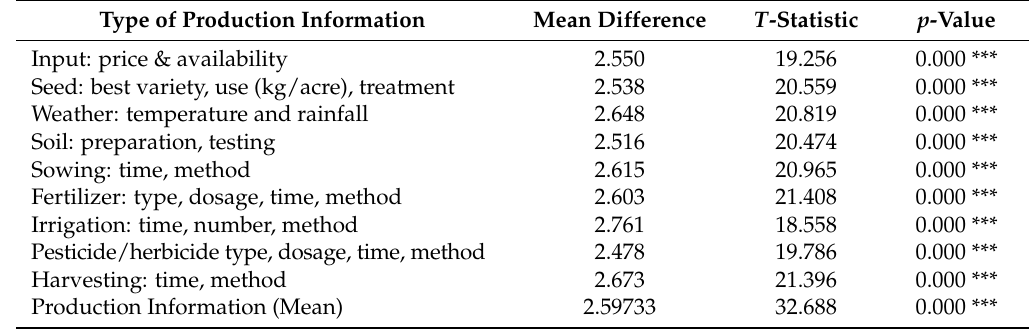
Table 4. Results of student’s t -test of the differences in access to different types of production information. Type of Production